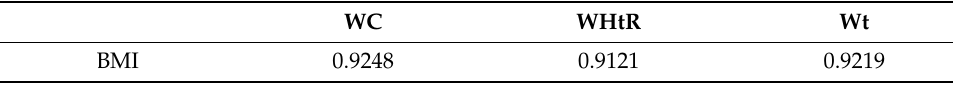
Table 4. Correlation coefficients of WC with WHtR and weight (Wt).